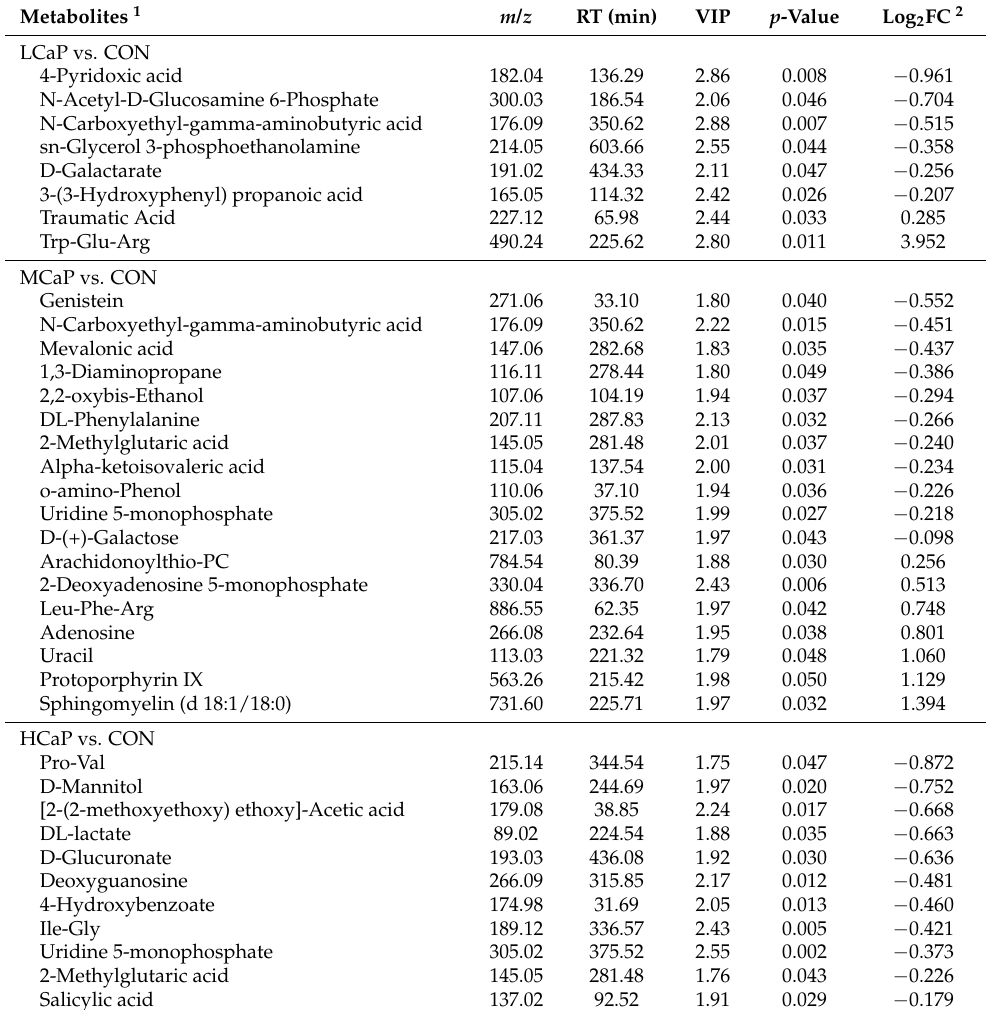
Table 3. The significantly different milk metabolites of early-lactation dairy cows supplemented with different levels of calcium